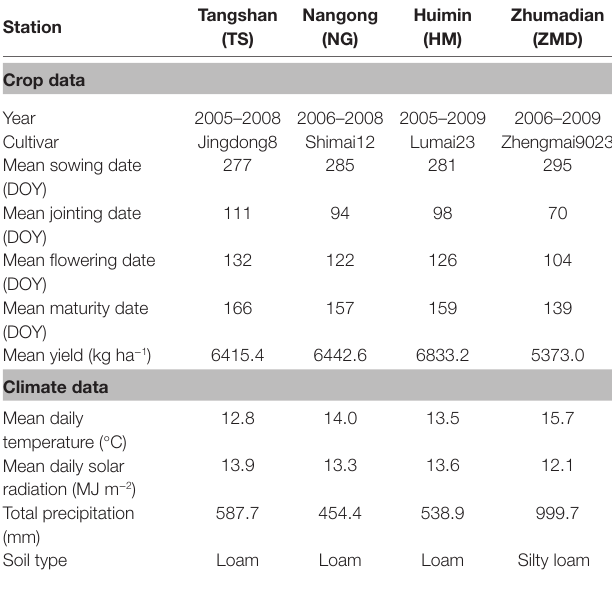
TABLE 1 | General information about crop and climate data for the four investigated stations in the North China Plain